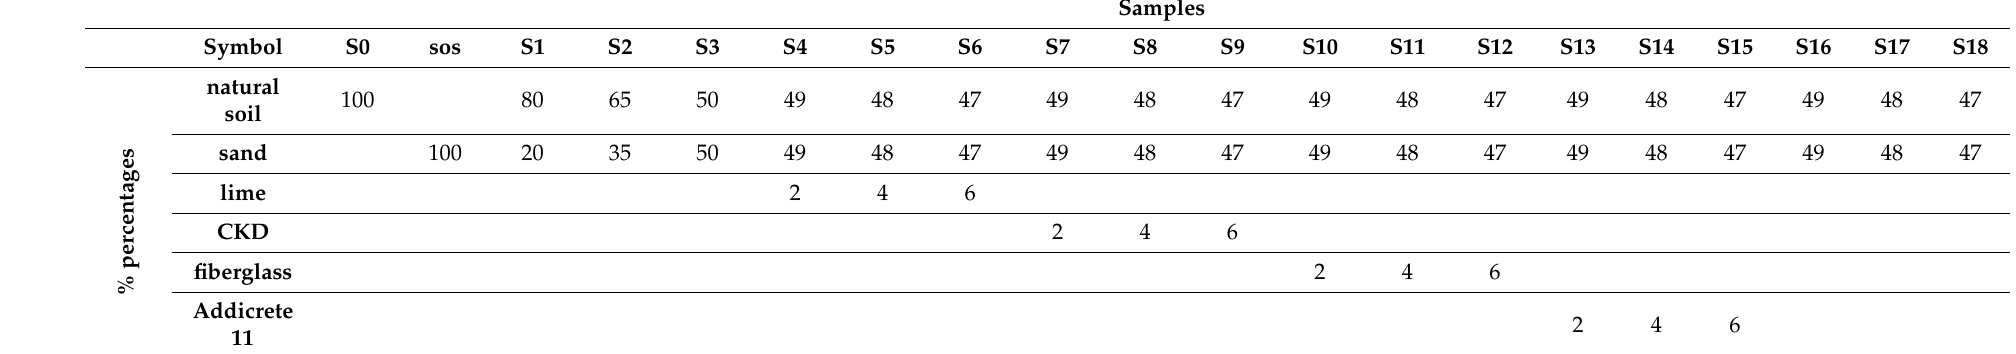
Table 1. Properties of samples